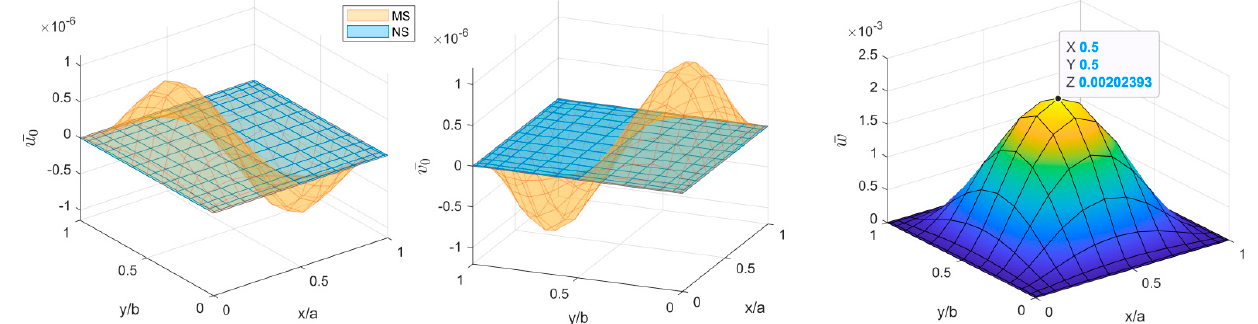
Figure 5. Identical solutions generated by both MS and NS formulations. In-plane displace- ments u NS , v NS (blue surfaces) and u MS , v MS (orange surfaces) for a fully clamped square plate ( a / h = 100, n z = 0.5, n x = 0 ) .